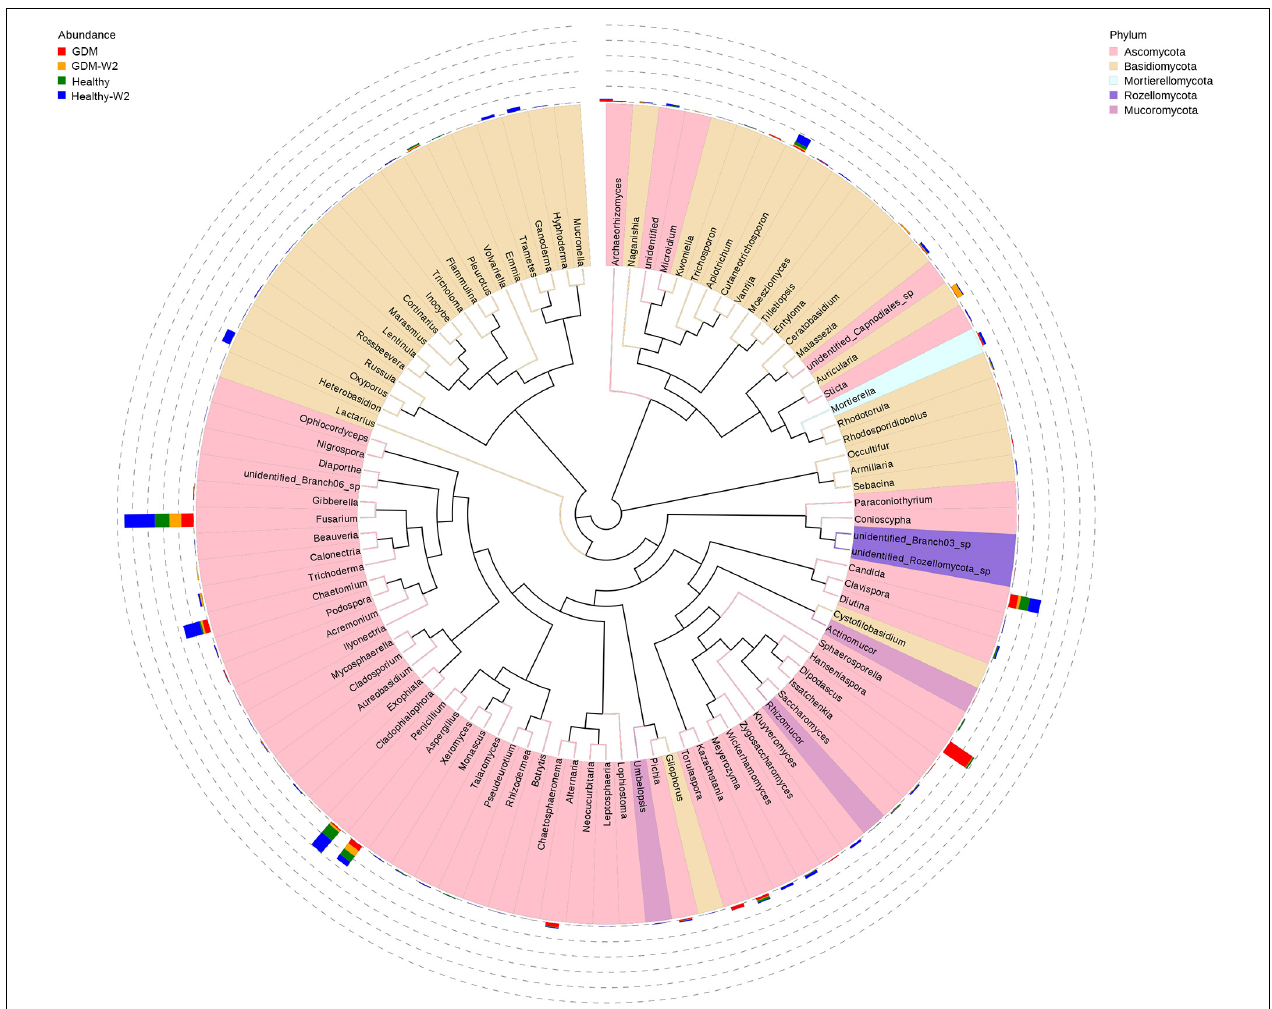
FIGURE 2 | Phylogeny tree shown top 100 genera in the four groups, including the GDM and healthy and the GDM-W2 and healthy-W2 groups. 23 GDM patients and 26 healthy